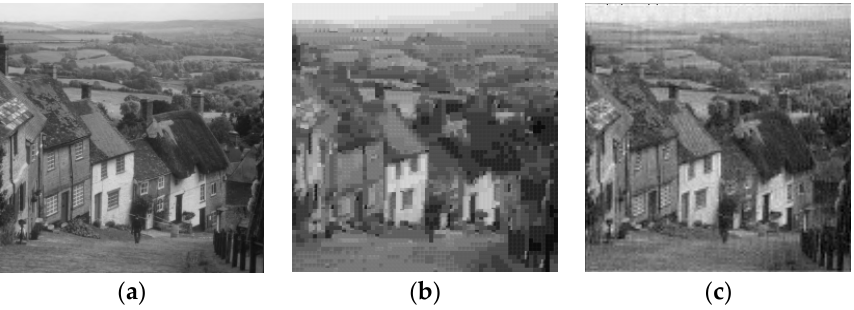
Figure 5. Images Goldhill: ( a ) Original; ( b ) Reconstructed using spatial domain VQ with 0.3125 bpp (PSNR = 25.71 dB and SSIM = 0.6391); ( c ) Reconstructed using DWT VQ with 0.3125 bpp (PSNR = 26.81 dB and SSIM = 0.7640). Codebooks were designed with training set P-M-T by MFKM2-ENNS.